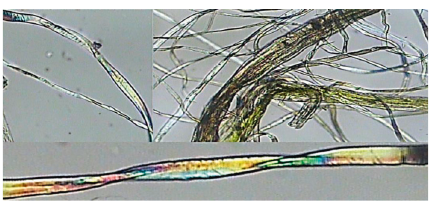
Figure 4: Longitudinal view of the fiber